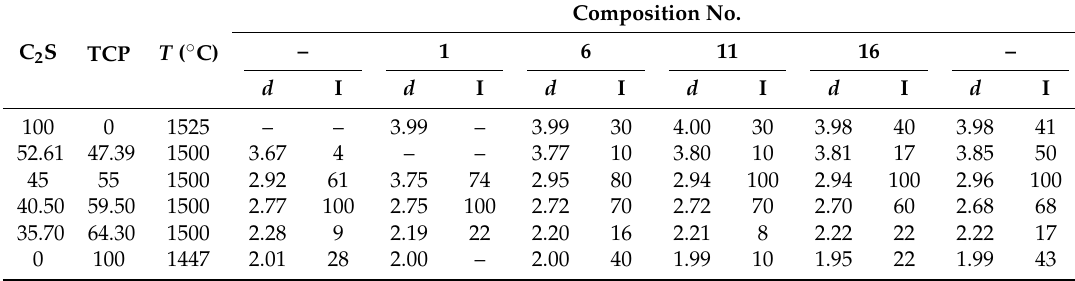
Table 3. d values for the six strongest lines of the phase R quenched at 1500 °C after 144 h, together with the d values of the pure α ´-TCP (JCPDS card number 89-8960) and α -C 2 S (JCPDS card number 87-1260) for comparison purposes. Compositions are in wt %.